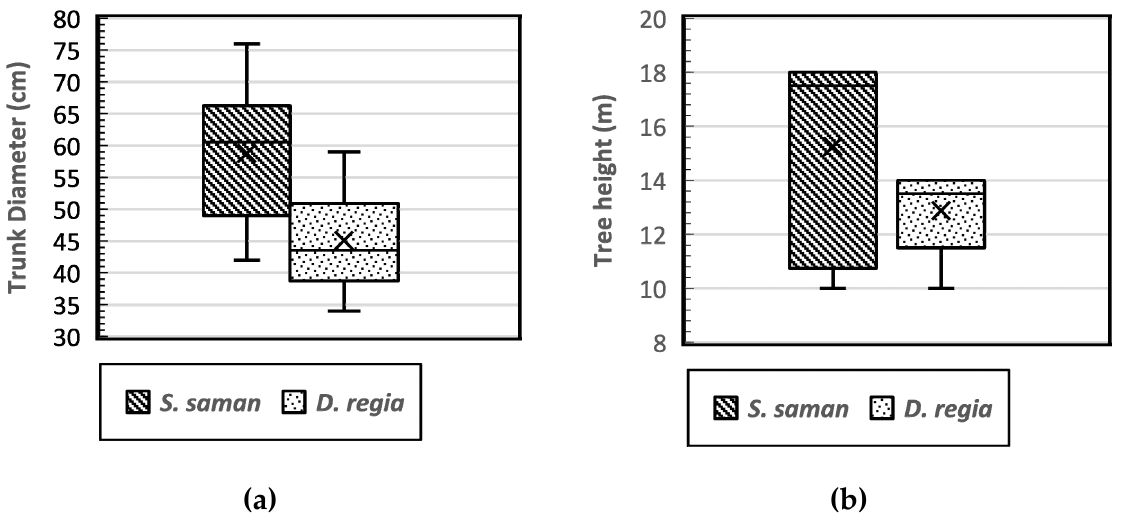
Figure 4. The example of tree appearance of (a) rain tree ( Samanea saman ) and (b) flamboyant tree ( Delonix regia ) in the urban landscape.